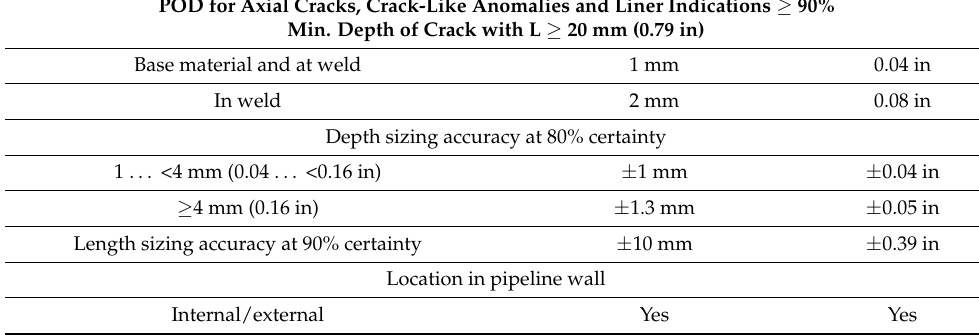
Table 3. Inspection accuracy of EVO SERIES 1.0 UC inspection tool.